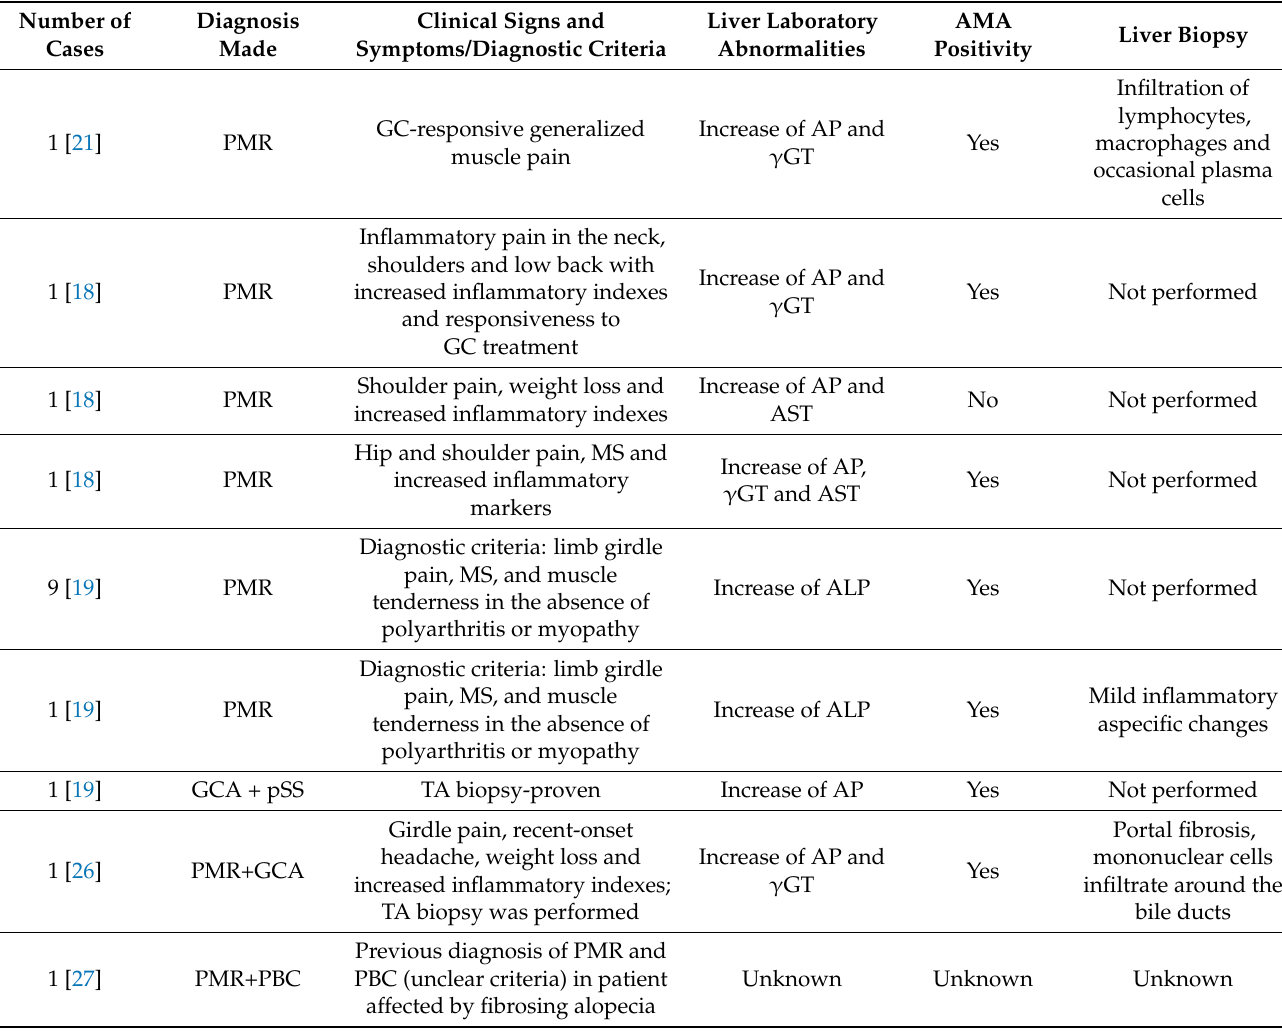
Table 1. Case series reporting an association between PMR/GCA and AMA